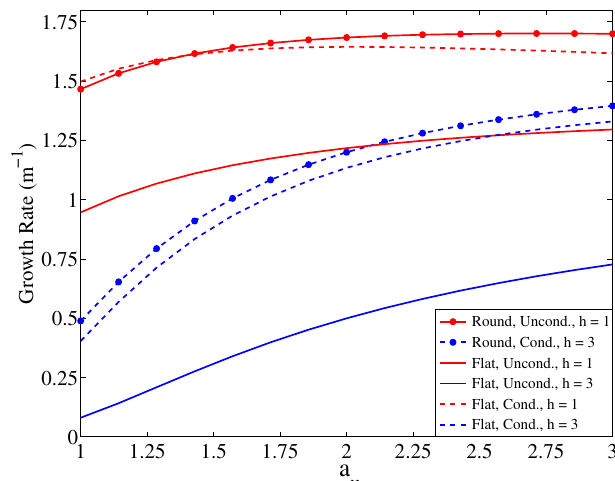
FIG. 4. (Color) Dependence of the growth rate on the undulator (and hence beam energy) for various configura- parameter a u tions of a soft x-ray FEL at 3 nm with 1 cm undulator period. Configurations vary between round or flat beams, beams with or without conditioning, and extraction of the fundamental or the third